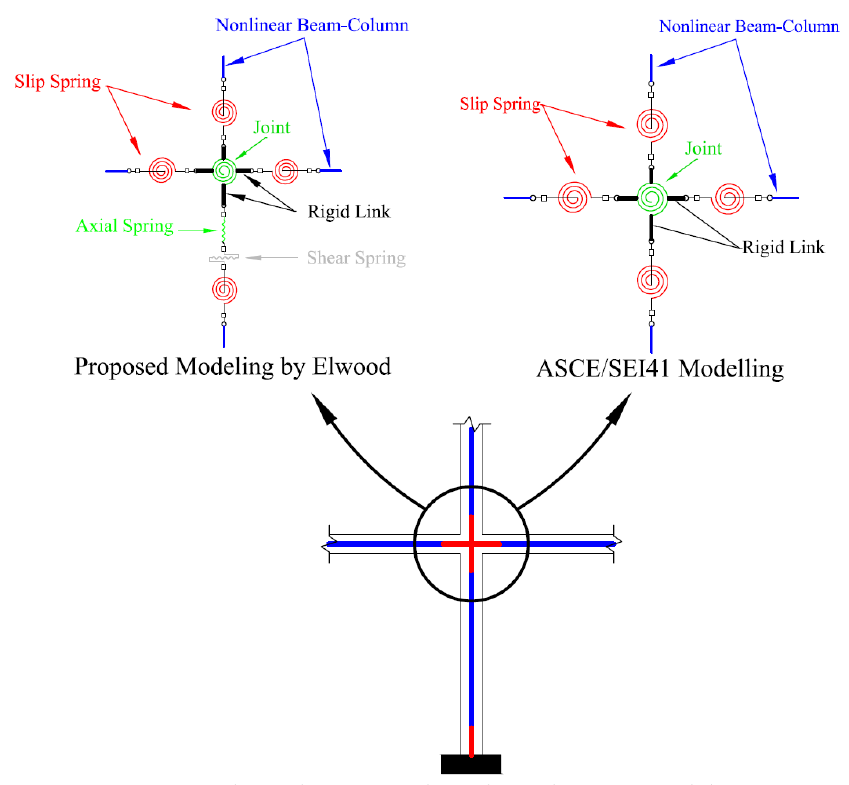
Fig. 5. Schematic presentation of 3 and 5 story